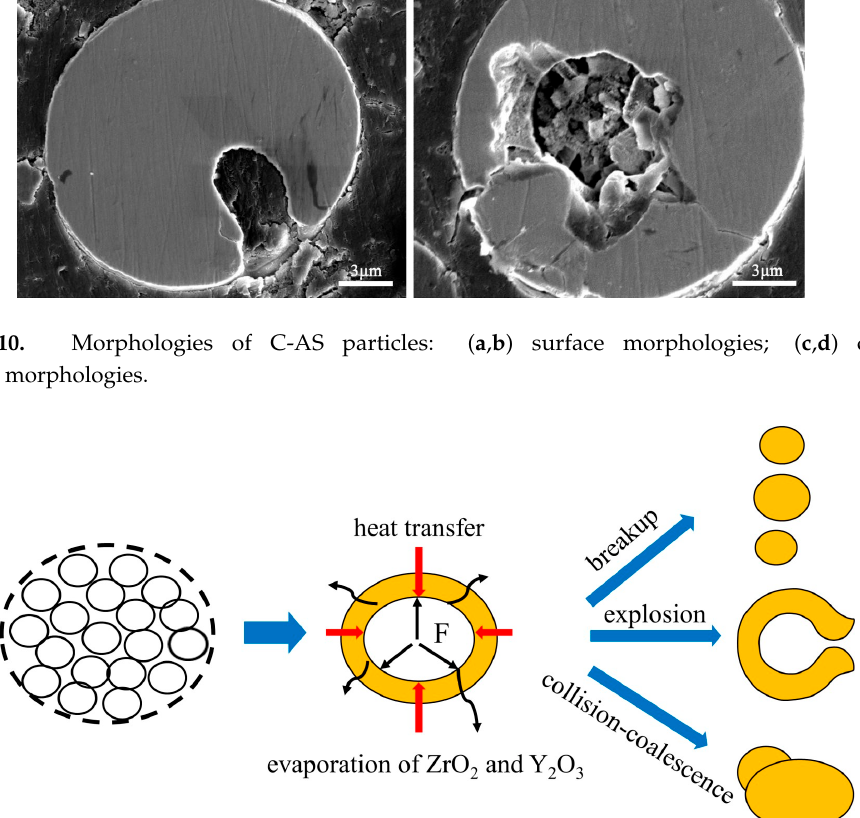
Figure 11. Schematic diagram of the development of physicochemical properties of YSZ particles in-flight during the SAPS process.